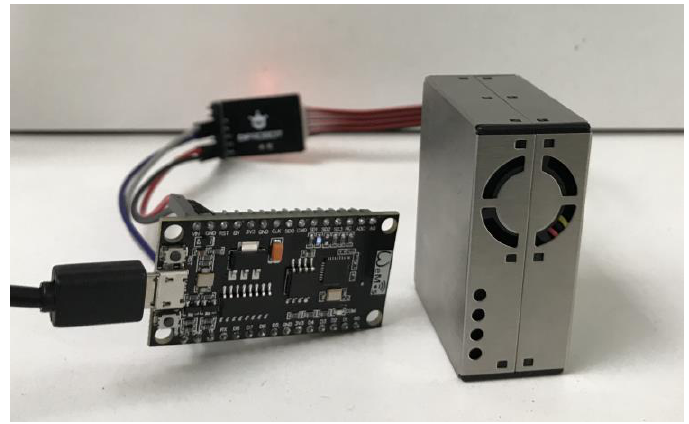
Figure 2. AirPlus acquisition module.